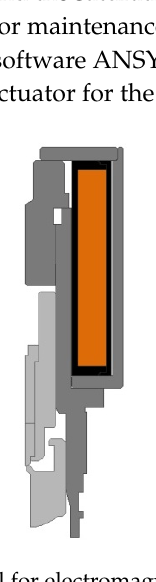
Figure 10. 2D model for electromagnetic field